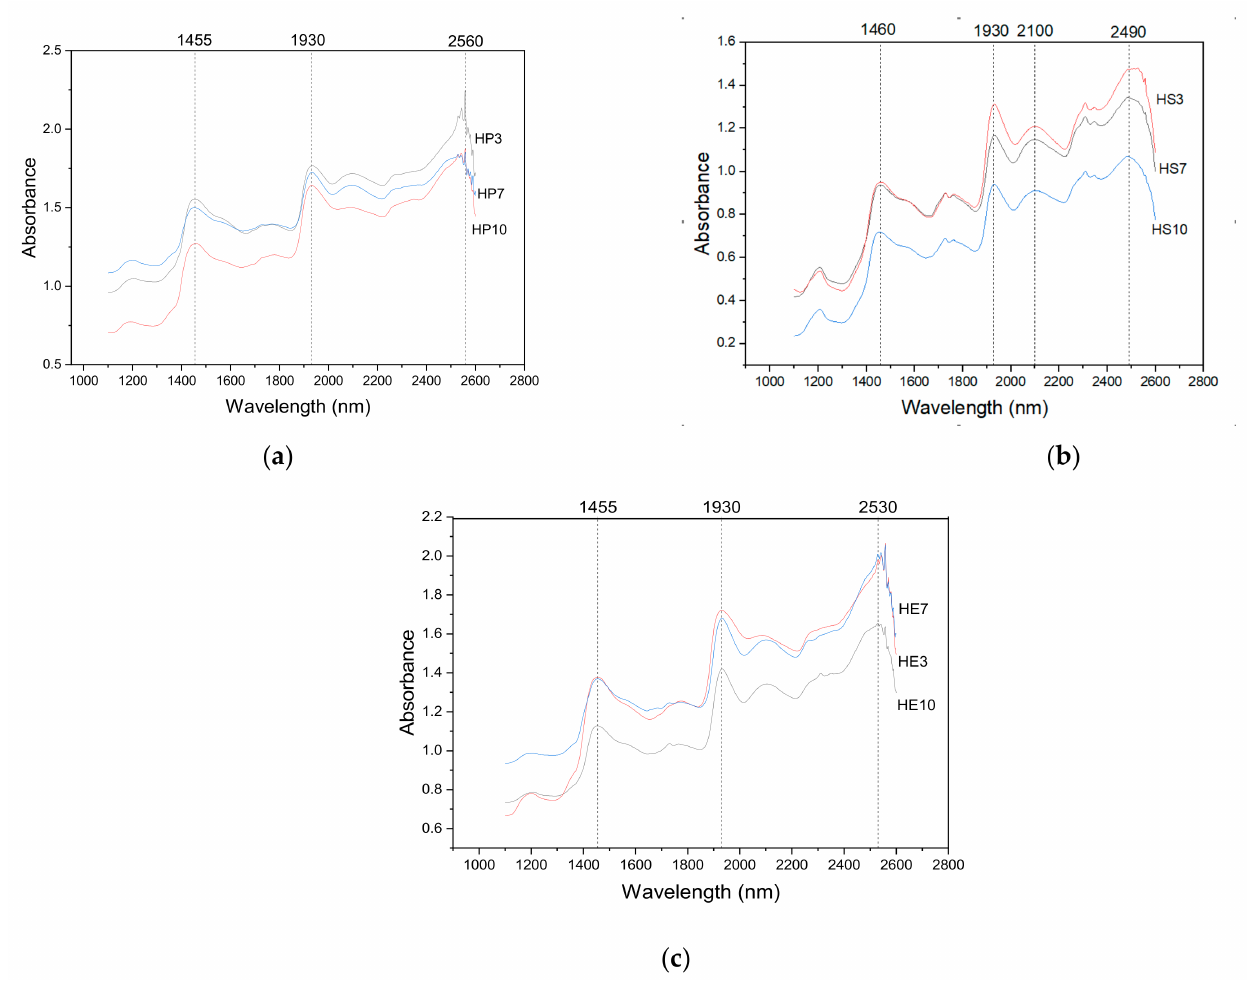
Figure 2. Representative NIR spectra of hydrocolloid; ( a ) Pulp; ( b ) Seed; ( c ).